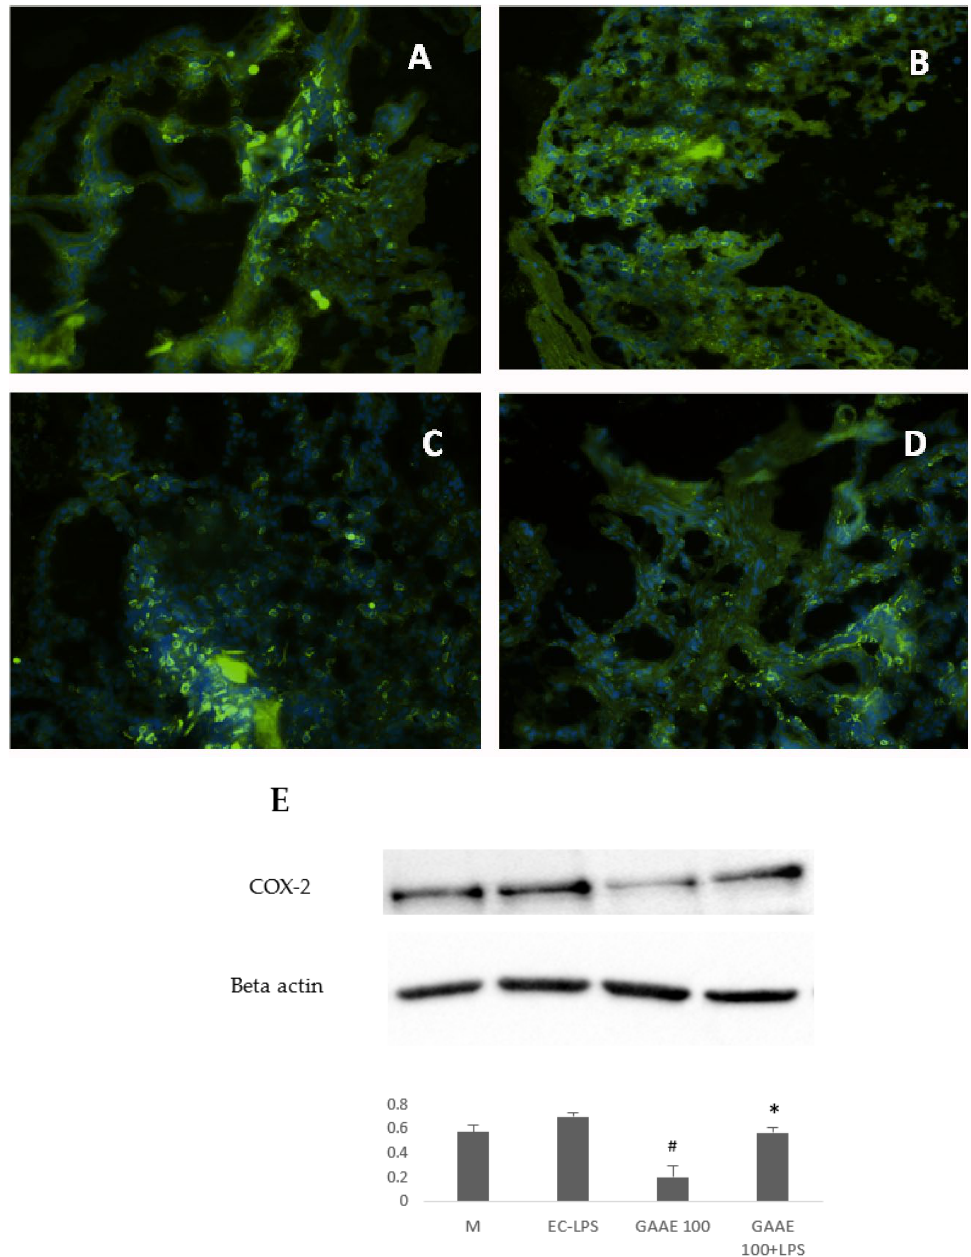
Figure 8. GAAE pre-treatment effect on COX-2 expression in UC patient biopsies challenged with EC-LPS. ( A ) Non-treated biopsy; ( B ) biopsy challenged with 1 µ g/mL EC-LPS; ( C ) biopsy treated with 100 µ g/mL GAAE; ( D ) biopsy co-treated with 100 µ g/mL GAAE and 1 µ g/mL EC-LPS; ( E ) Western blotting with the same treatments. Results are expressed as means ± S.E.M. ( N = 31), * p < 0.05 vs. EC-LPS, # p < 0.05 vs. medium (Student’s t - test).